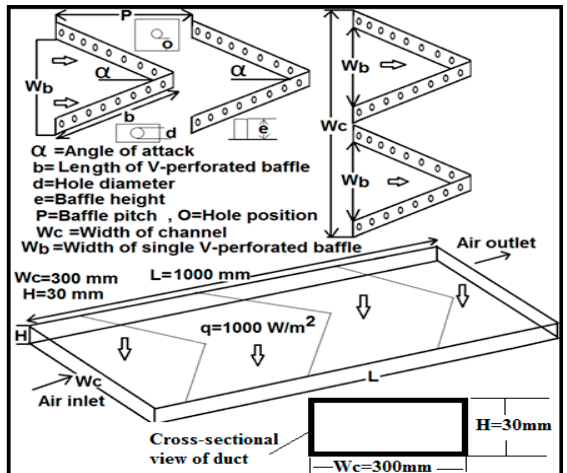
Figure 1. Multi V-shaped perforated baffle shape.